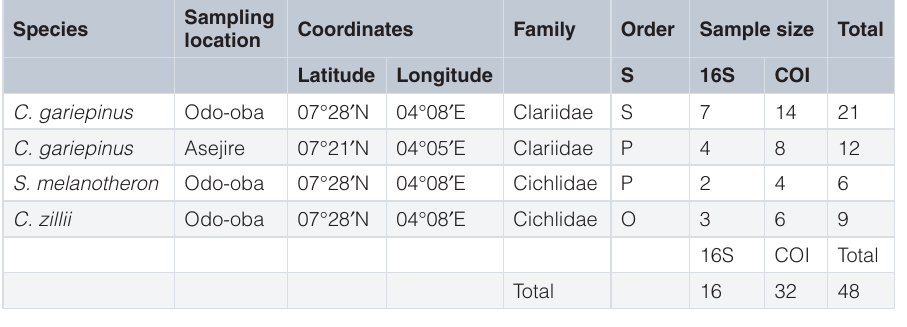
Table 1. Species, sampling location and coordinates utilised for the DNA barcoding of the three studied species.